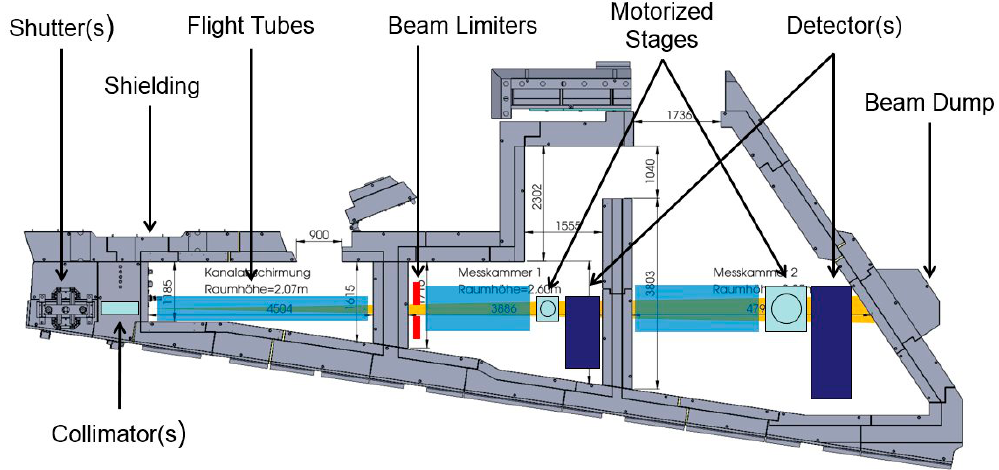
Figure 2. The ANTARES neutron imaging facility at the FRM II reactor, with the reactor to the left, and two measurement chambers. The irregular shape is given by external walls and other neighboring instruments.